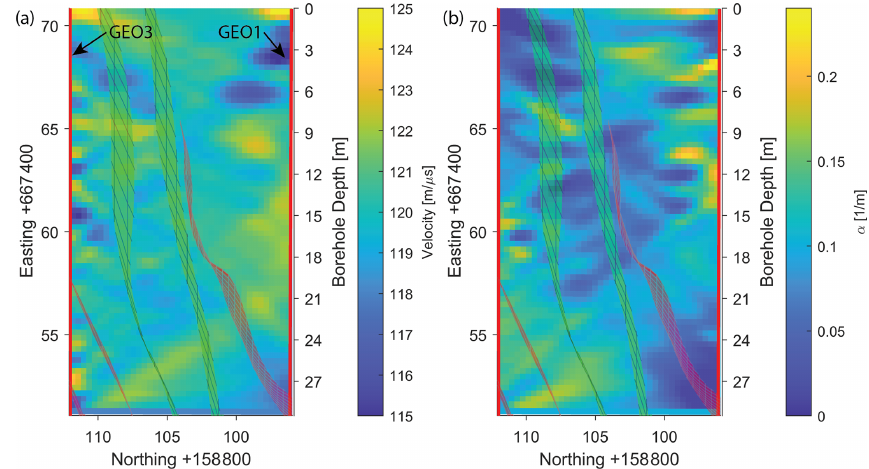
Figure 7. Results of the baseline inversion. Panel (a) shows the velocity result, while (b) shows the attenuation. GEO1 and GEO3 are shown in red; the S1 (red) and S3 (green) shear zones are also depicted for orientation.